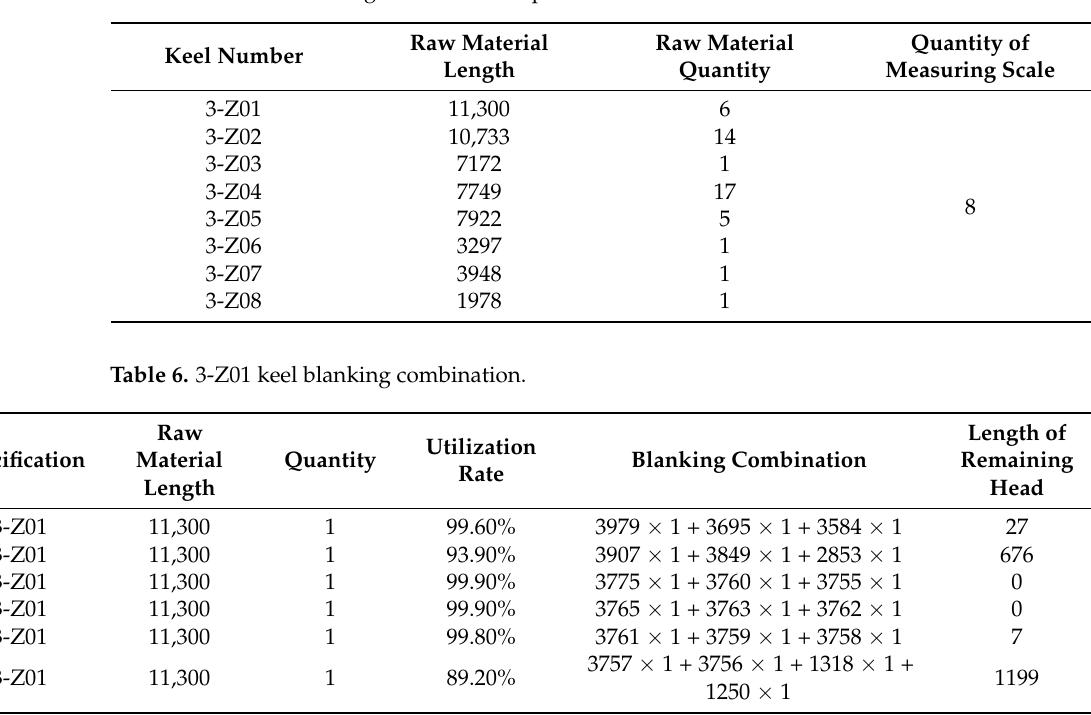
Table 5. Raw material length of the three-span and one-break main curved keel.